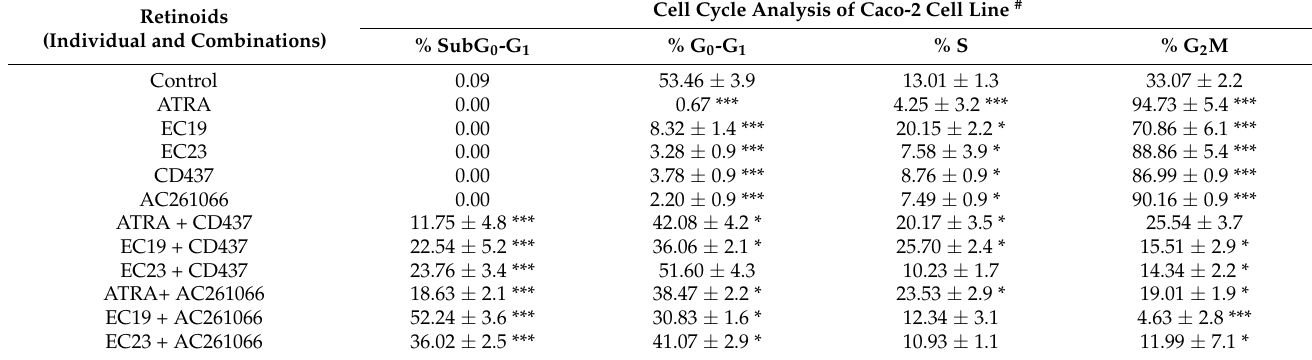
# Data represent mean ± SEM, n = 3. The significance in p-values for comparison with control untreated cells (0.1%DMSO solvent only) is indicated (either increase or decrease) as * p < 0.05, *** p <